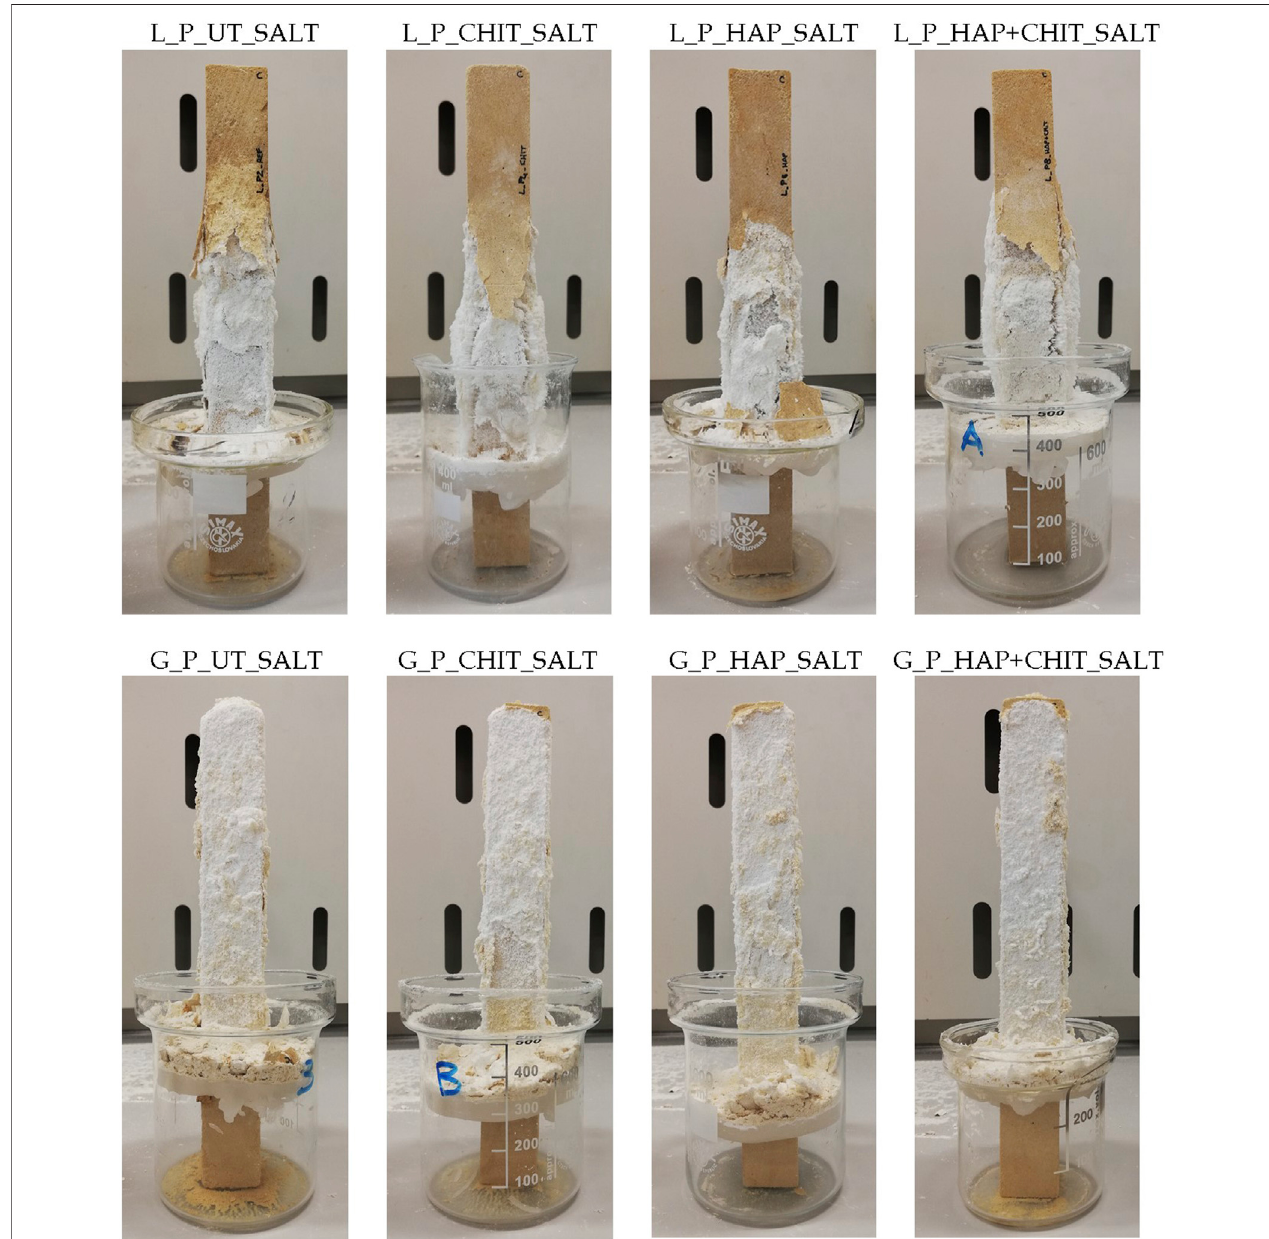
FIGURE 10 | Prismatic samples at the end of the second continuous absorption test, before